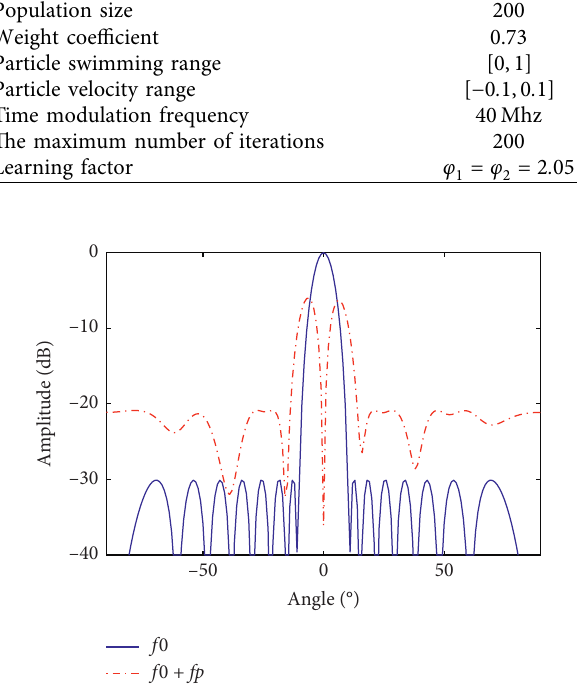
Figure 6: Sum and difference beam pattern ( θ Table 3: Comparison of sum and difference beam parameters.